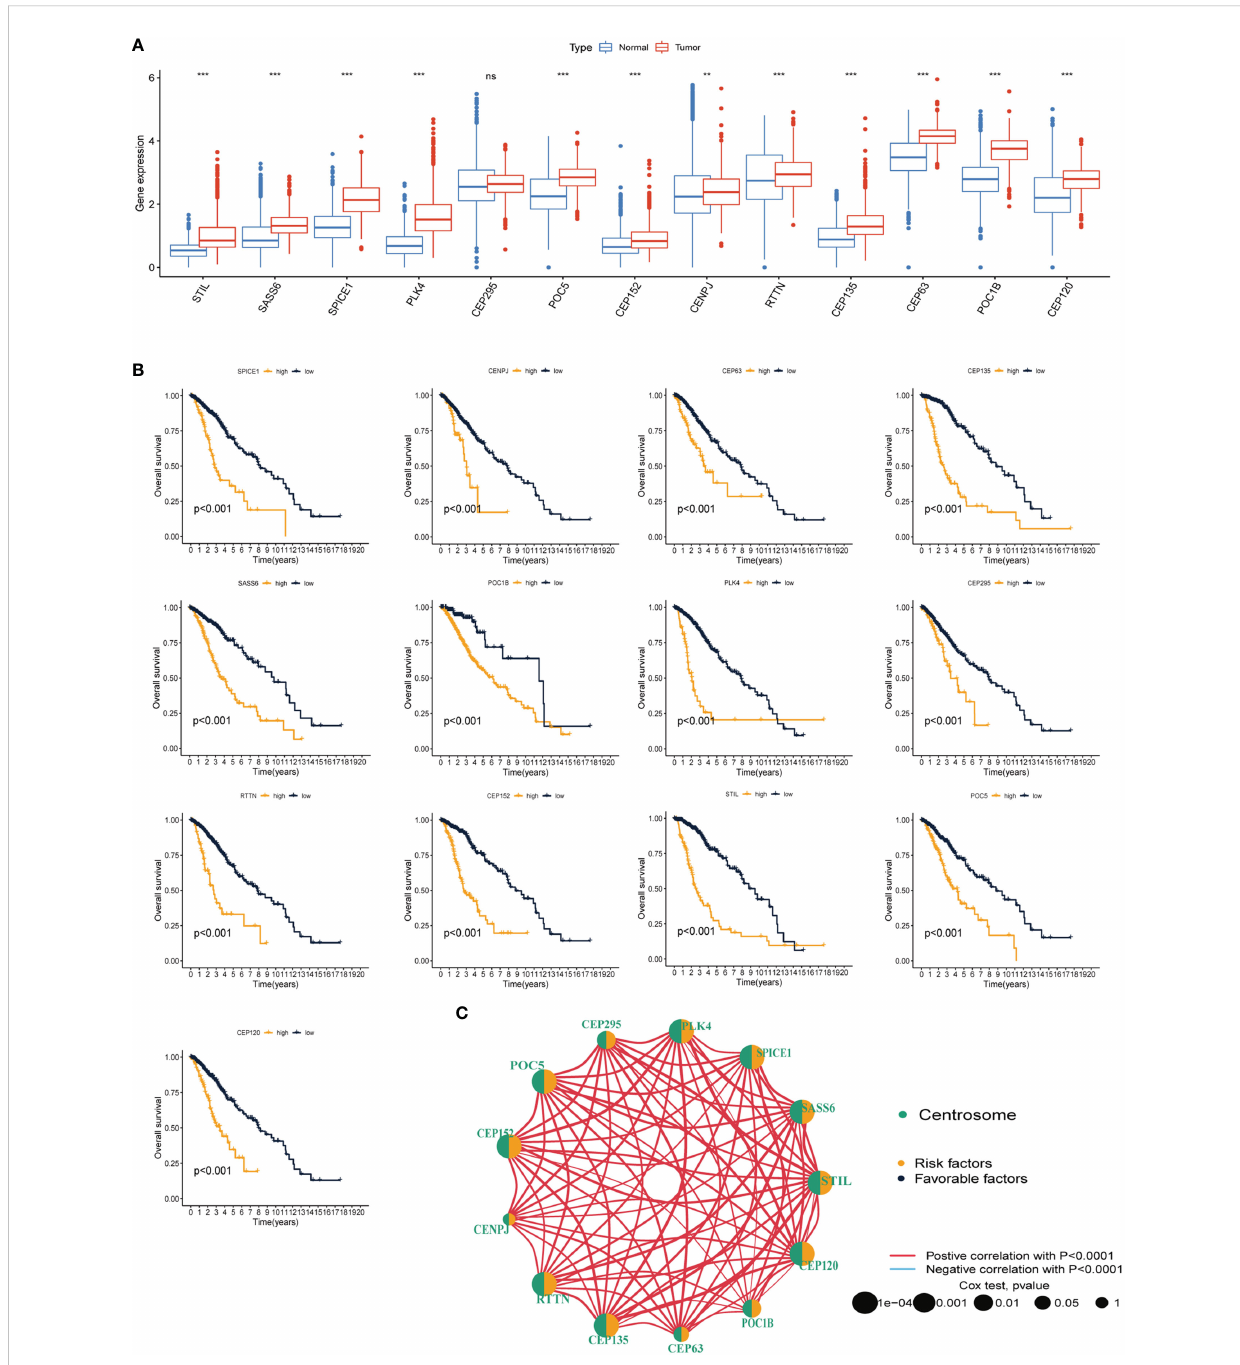
FIGURE 2 Differential expression and prognostic analysis of thirteen CRGs in TCGA-LGG cohort. (A) Differential expression of thirteen CRGs in LGG and normal tissue. (B) K-M survival analysis of thirteen CRGs in LGG. (C) Correlation network analysis of thirteen CRGs. The line represents the correlation between genes, the sphere represents the univariate Cox test of each gene. CRGs, centrosome related genes; **p < 0.01, ***p < 0.001, ns, not statistically signi fi